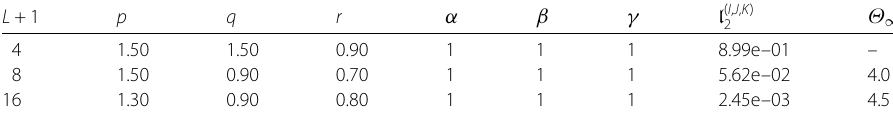
Table 1h Errors for the EF-EEG-TOCS in Example 5.1 at τ = 0.01 L + 1